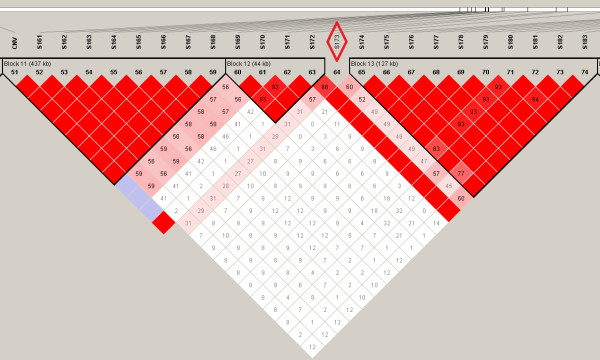
Linkage disequilibrium plot based on D' for the SNP in the CNV region. Key: when LOD < 2, D' < 1 is white and D' = 1 is blue; when LOD > 2, D' < 1 is given in shades of pink/red and D' = 1 is given in bright red; the pair-wise D' values are given in the boxes.